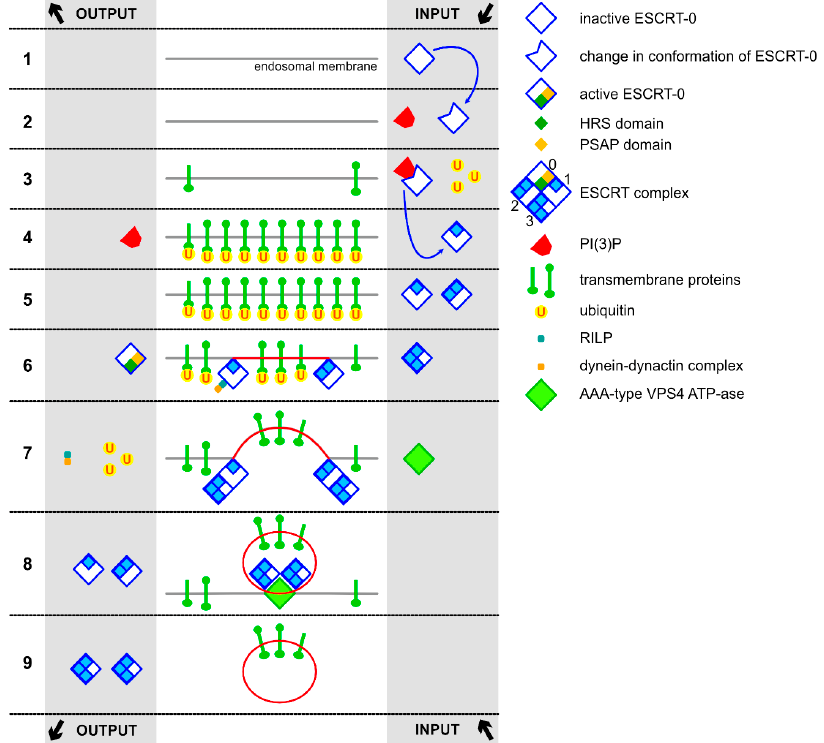
Figure 3. The endosomal sorting complexes required for transport (ESCRT)-dependent mechanism of sorting of ubiquitinated cargo into the multivesicular precursor of exosomes. The process involves accumulation and ubiquitination of transmembrane proteins on to the late endosomal membrane, followed by recruitment of phosphatidylinositol 3-phosphate (PI(3)P), ESCRT complex (ESCRT-0, ESCRT-1, ESCRT0-2, ESCRT-3), RAB-interacting lysosomal protein (RILP), dynein-dynactin complex, AAA-type vacuolar protein sorting-associated protein 4 (VPS4) ATP-ase, respectively. Following